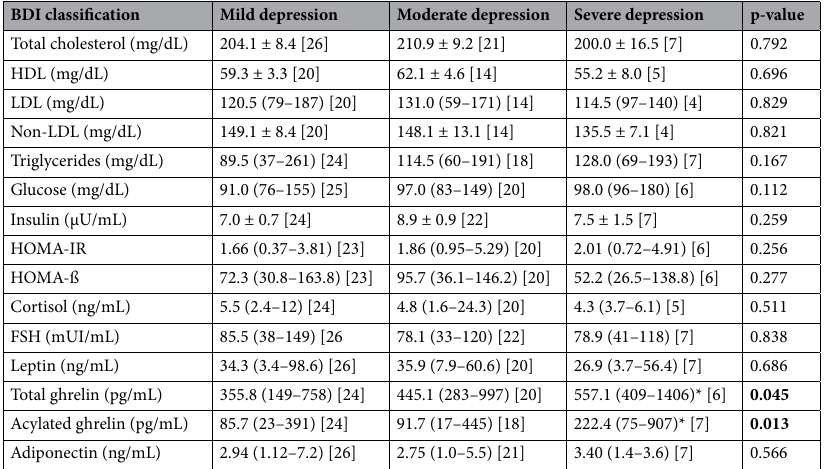
Table 3. Clinical data. Variables with normal distribution were analyzed by ANOVA and presented as mean ± standard error [n]. Variables not normally distributed were analyzed by Kruskall–Wallis test and presented as median (minimum–maximum) [n]. *Vs. mild depression. Bold values indicate statistical significance of p < 0.05.